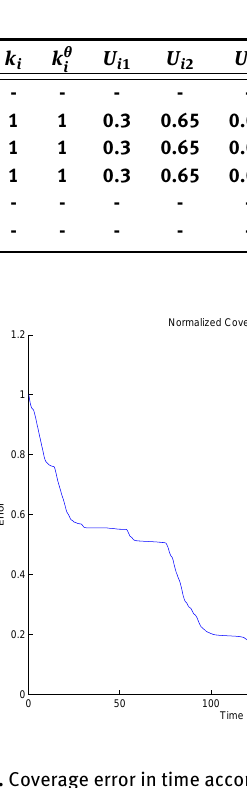
Table 1. Table of example simulation parameters.